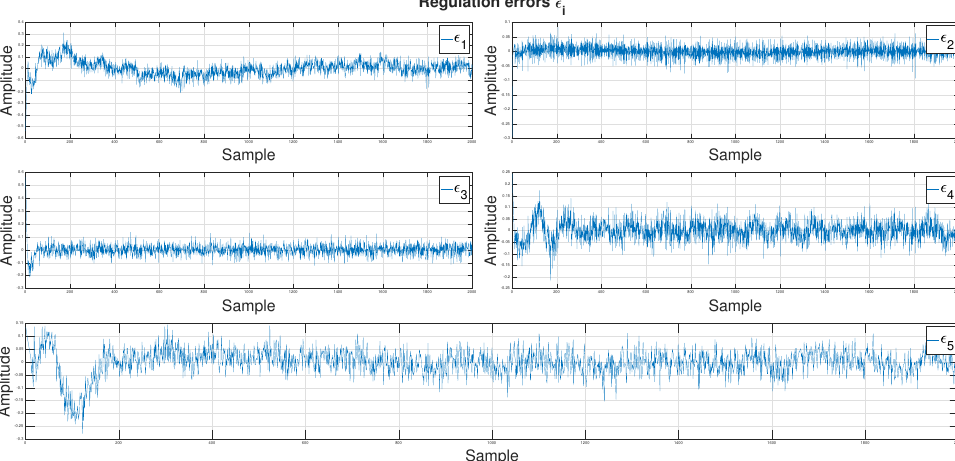
Figure 4. Control errors time series for the simulation data impacted by the Gaussian